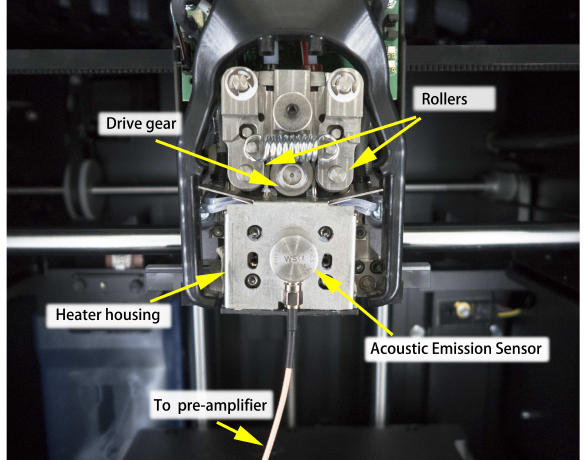
Figure 6. Sensor